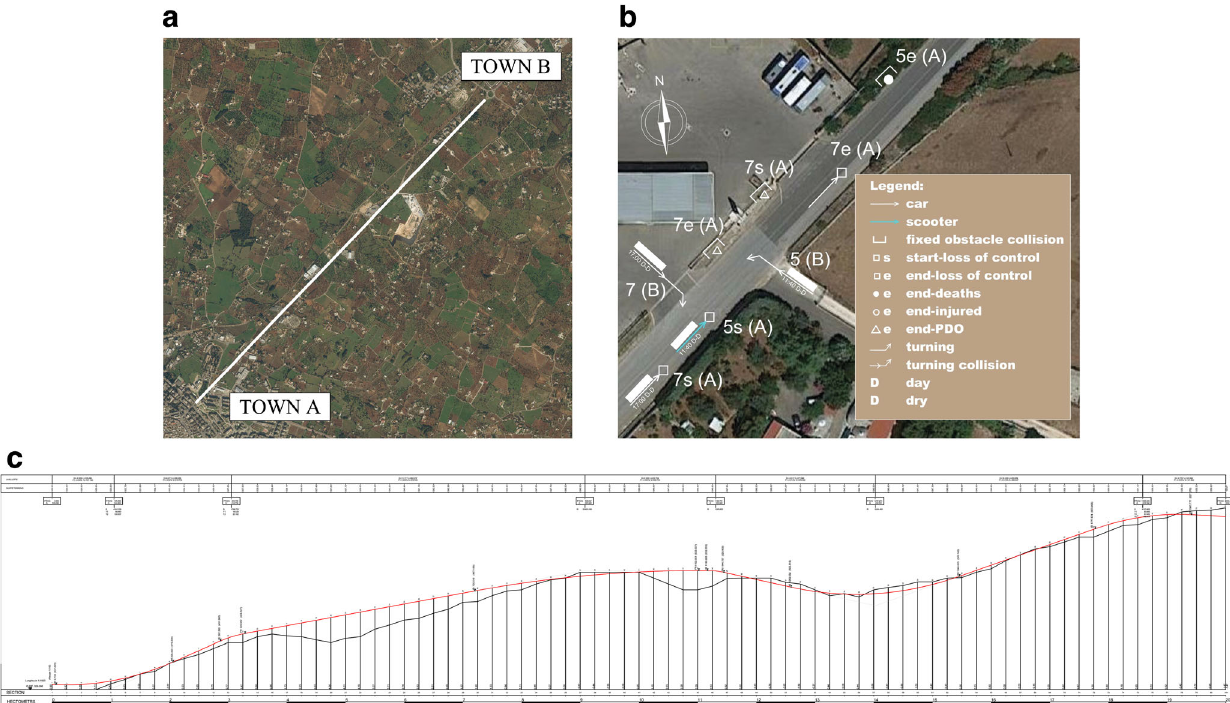
Fig. 8 Site PP2. a Overview, b Collision Diagram of a road stretch, c Elevation